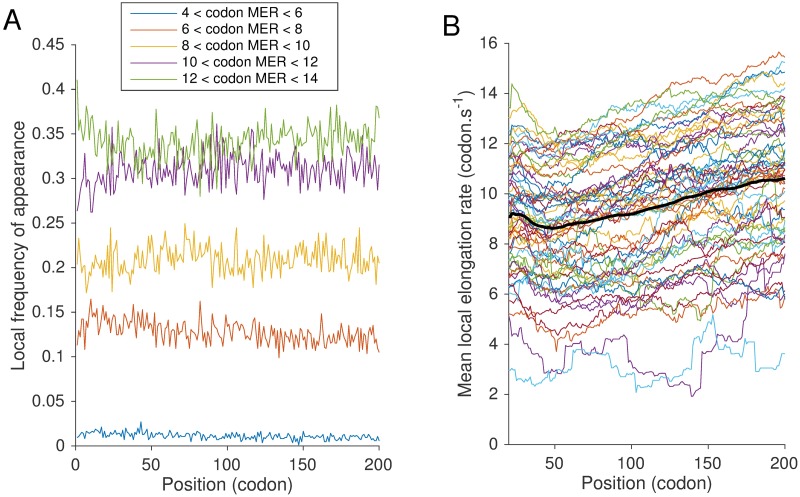
Heterogeneity of codon distributions and elongation speed along the transcript.A. Codon frequency metagene analysis. We grouped the codons (except stop codons) into five groups according to their mean elongation rates (MER) and plotted their frequency of appearance at each position in the set of genes we considered. The first group contained 4 codons with MER between 4 and 6 codons/s; the second group 13 codons with MER between 6 and 8; the third group 13 codons with MER between 8 and 10; the fourth group 16 codons with MER between 10 and 12; and the fifth group 15 codons with MER > 12. B. Smoothed mean elongation speed along the ORF for each codon type (stop codons are excluded). At each position i, we computed an average of codon-specific MER between positions i − 20 and i + 20. In black, we plot an average of the 61 curves.